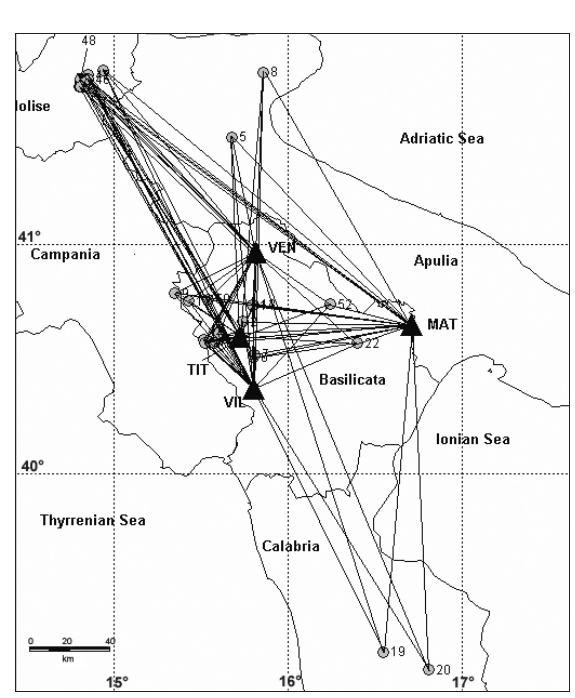
Fig. 1. Location of earthquakes and seismic stations used. The circles with identification number are the epi- centers (see also table I) and the triangles are the location of the stations. We also draw the source-station paths.